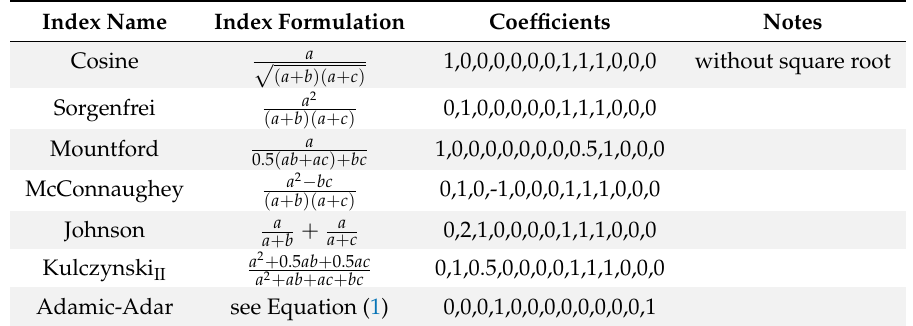
Table 2. µ 2 subsumed